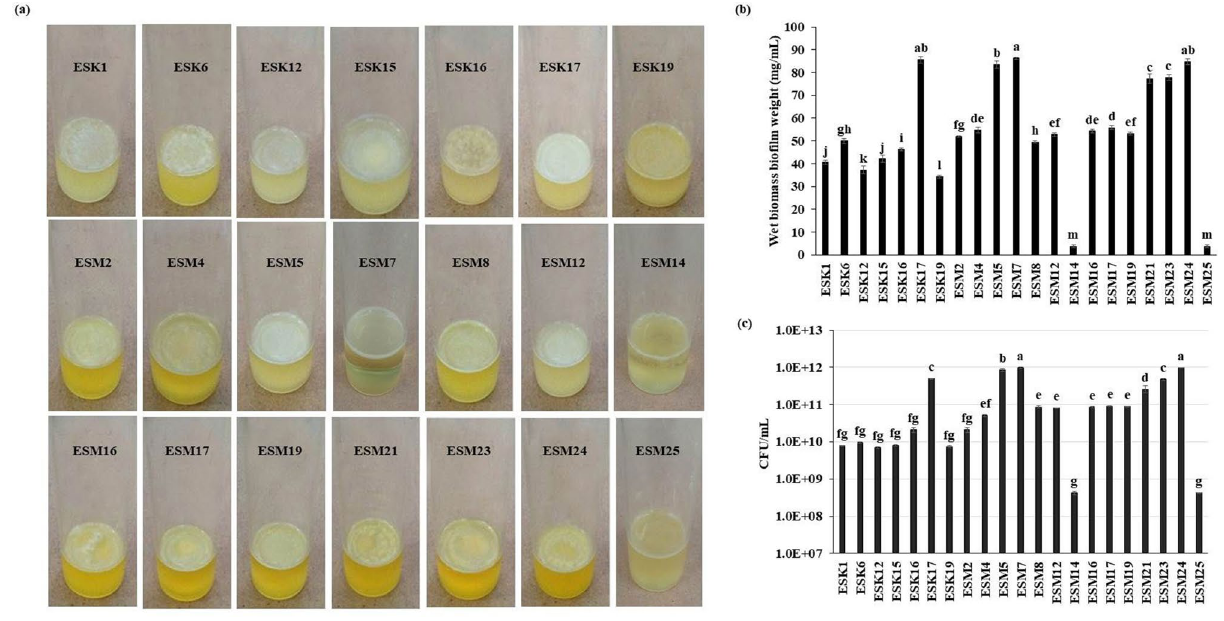
Figure 1. Biofilm formation by different rhizobacterial isolates in the glass test tubes containing 5 mL SOBG supplemented with 5% NaCl after 72 h incubation in a static condition at 28 °C ( a ). Biomass (wet) biofilm production by various isolates ( b ). Number of bacteria associated with biomass biofilm ( c ). The values are mean and error bars indicate standard deviation ( ±) of the three independent experiments. Values having different letters are significantly different from each other according to Fisher’s least significant difference (LSD) test ( P ≤